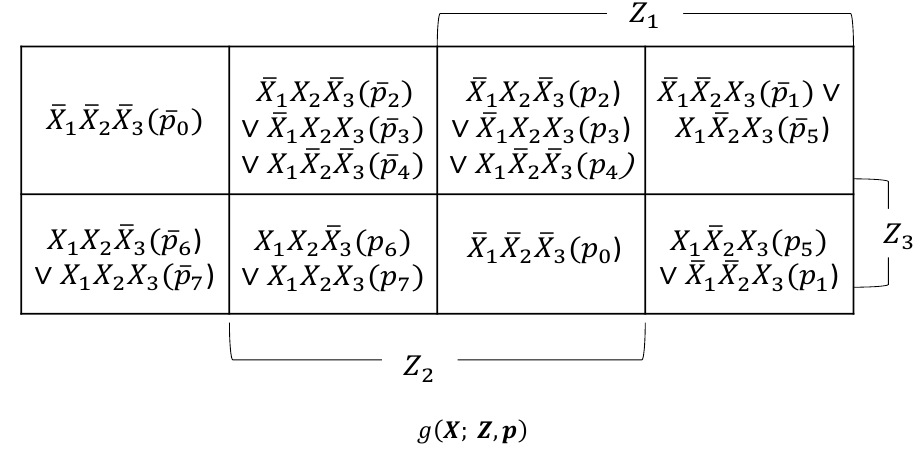
Fig. 4. The auxiliary function for Example 1